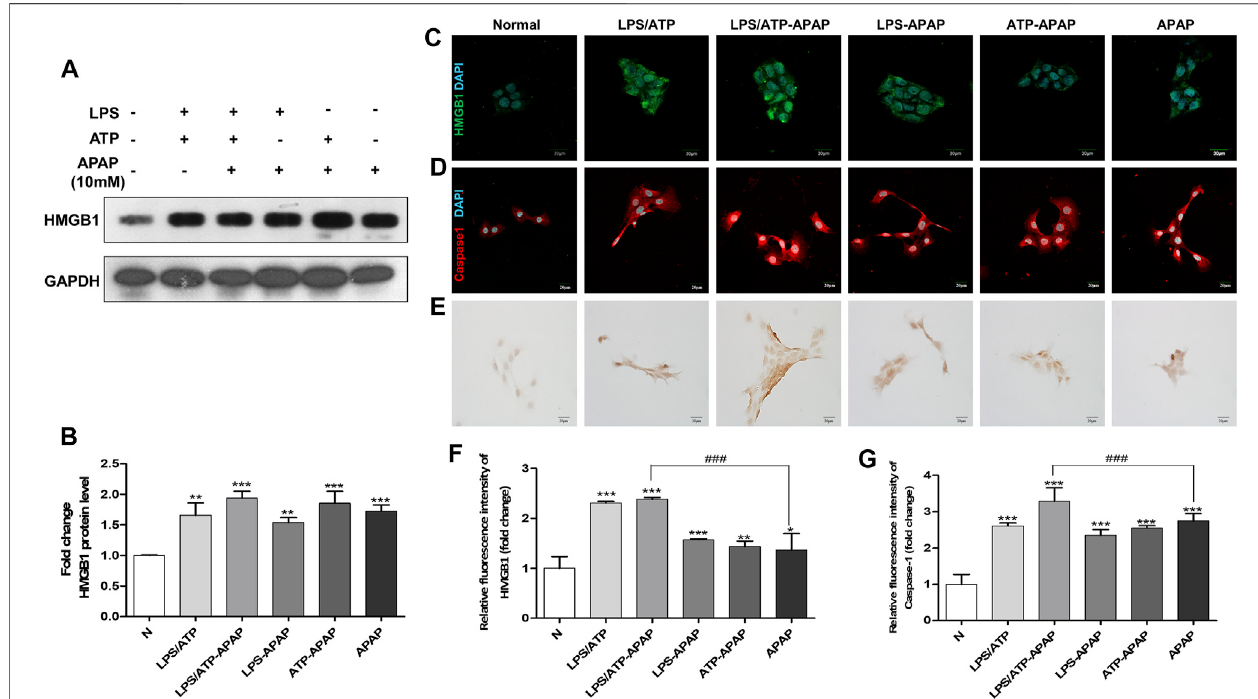
FIGURE 2 | Changes in in fl ammatory indexes in vitro model of APAP induced by LPS/ATP combined with stimulation. (A,B) HMGB1 protein expression and quantitative analysis relative to GAPDH. (C,D) Immuno fl uorescence staining of HMGB1 and Caspase-1, the image is magni fi ed 600 × . (E) TUNEL staining, the image is magni fi ed400 × . (F,G) Relative fl uorescencequantitativeanalysisofCandD. # p < 0.05, ## p < 0.01, ### p < 0.001,signi fi cantlydifferentfromAPAPgroup.* p < 0.05,** p < 0.01, *** p < 0.001, signi fi cantly different from the normal group. One-way ANOVA followed by Tukey ’ s test. The data are expressed as the mean ± SD of fi ve independent assays with at least three replicates.